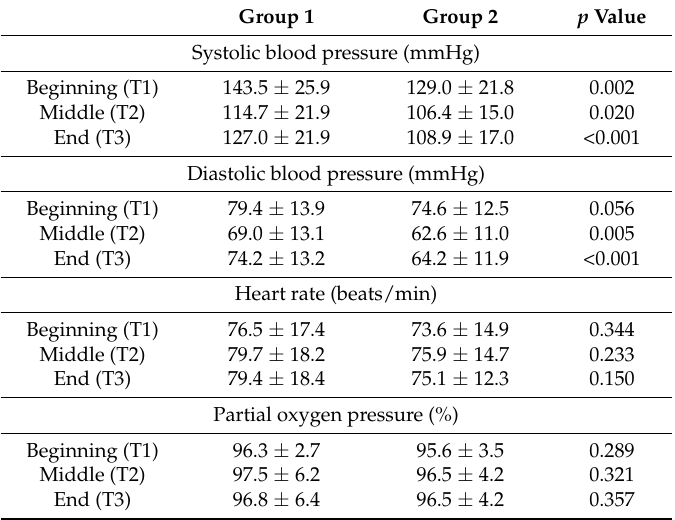
Table 2. Hemodynamic